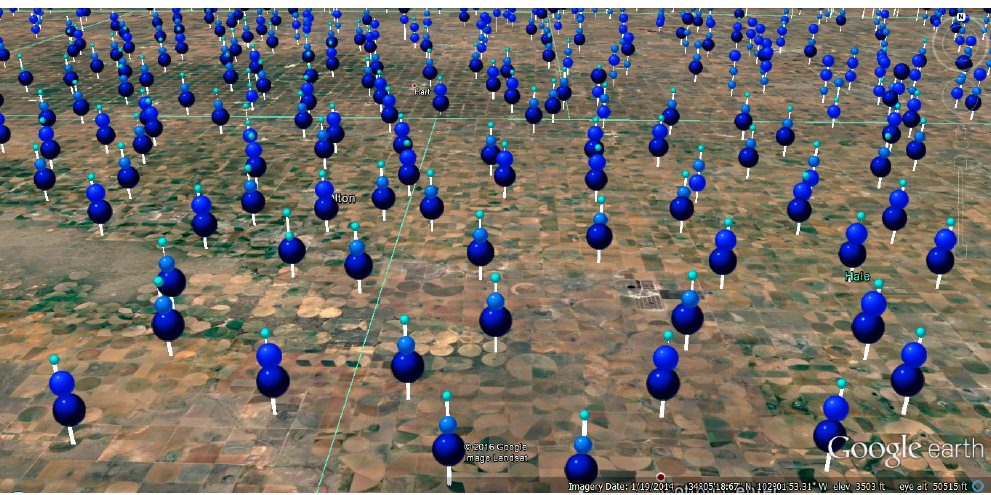
Figure 10. Screenshot of groundwater wells in a Texas region in 2003–2014. Source: Authors’ calculations and visualization.